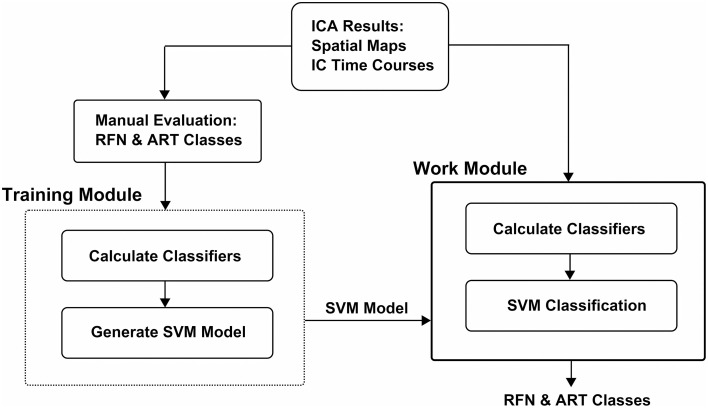
Pipeline schematic of FOCIS framework.